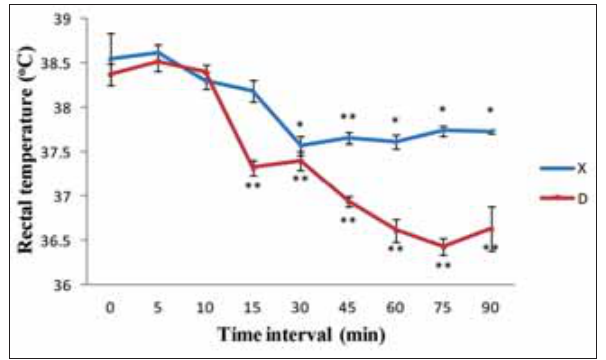
Figure-9: Mean±Standard error of diastolic blood pressure in animals of different groups. *Significantly different from the base value (p<0.05). **Significantly different from the base value